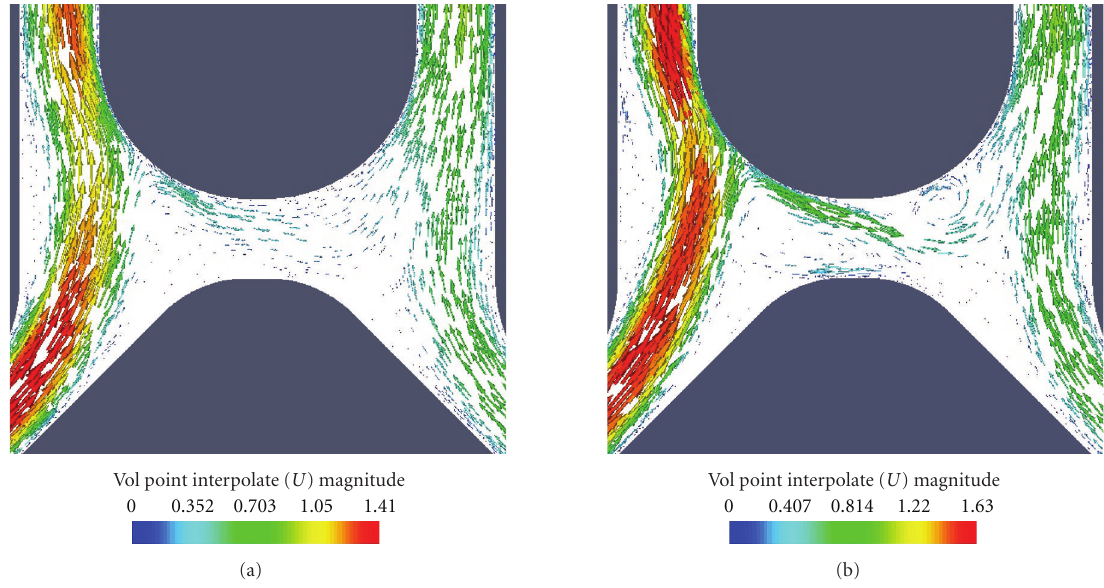
Figure 4: (a) Velocity field during systole and (b) early diastole with ACA flow rates set at Q R = 0 . 5 Q L . Left ACA impingement site moves rightward along the A2-ACOM adjoining wall as compared to the case where Q R = Q L with bifurcation of flow into the A2-ACA and ACOM segments. (b) A large vortex is generated on the right bifurcation site during diastole.